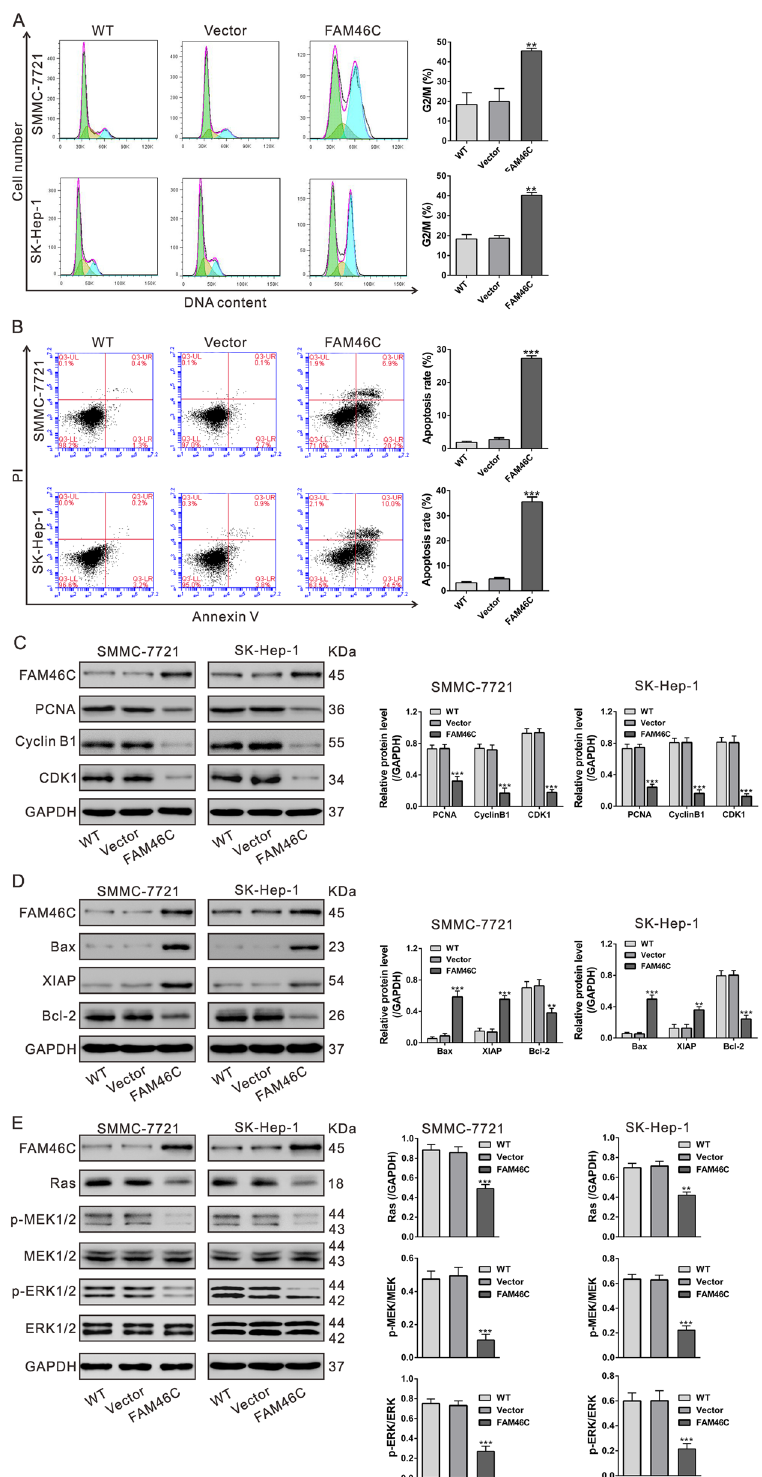
Figure 5. FAM46C overexpression resulted in G2/M phase arrest ( A ) and a significant increase of cell apoptosis ( B ) as determined by flow cytometry analyses at 48 h after viral infection. *** P < 0.001 as compared with Vector virus-infected cells. ( C ) Protein levels of FAM46C and cell growth-related factors (PCNA, Cyclin B1 and CDK1) were evaluated by Western blotting. ( D ) Protein levels of FAM46C and apoptotic factors (Bcl-2, Bax and XIAP) were assessed. ( E ) The levels of Ras, p-MEK1/2, MEK, p-ERK1/2 and ERK1/2 were evaluated. All experiments shown were performed independently at least three times. ** P < 0.01 and *** P < 0.001 as compared with Vector virus-infected